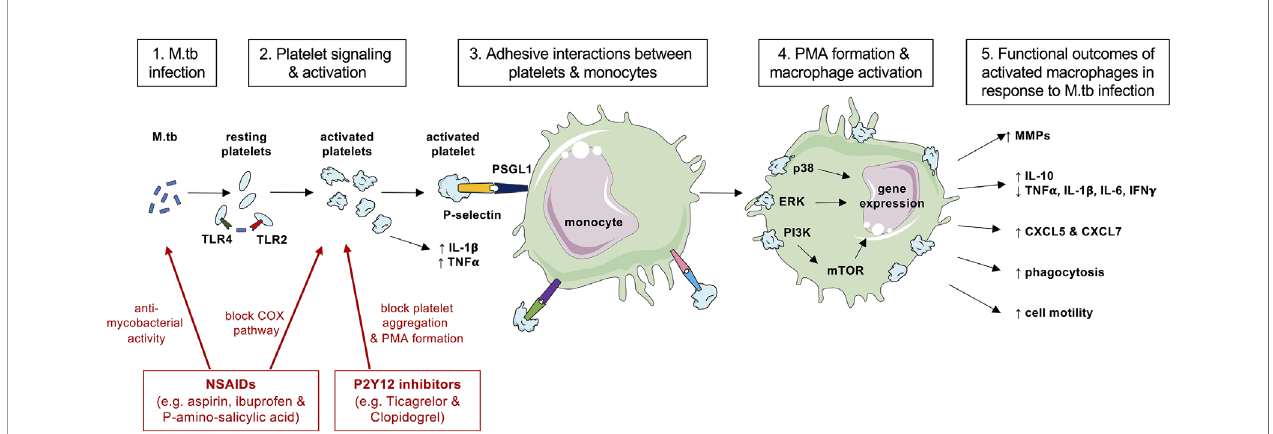
FIGURE 1 | A summary of cellular interactions between platelets and monocyte during M.tb infection and actions of anti-platelet therapies. Platelets may be able to directly sense M.tb infection (step 1) via TLR2 and TLR4 to become activated and degranulate to release pro-in fl ammatory cytokines (step 2). Activated platelets upregulate surface P-selectin expression and bind to PSGL1 on monocytes (step 3) leading to PMA formation (step 4). Ligation of PSGL1 can initiate signal transduction via MAPK and induce gene expression (step 4) to result in cellular functional outcomes such as MMP and cytokine production or phagocytosis (step 5). Anti-platelet agents such as non-steroidal anti-in fl ammatory drugs (NSAIDs) and P2Y12 inhibitors (shown in red) may exhibit direct anti-mycobacterial activity on M.tb or block the actions of platelets to decrease PMA formation and MMP expression that cause collateral host tissue damage. This fi gure was created with images adapted from Servier Medical Art by Servier. Original images are licensed under a Creative Commons Attribution 3.0 Unported